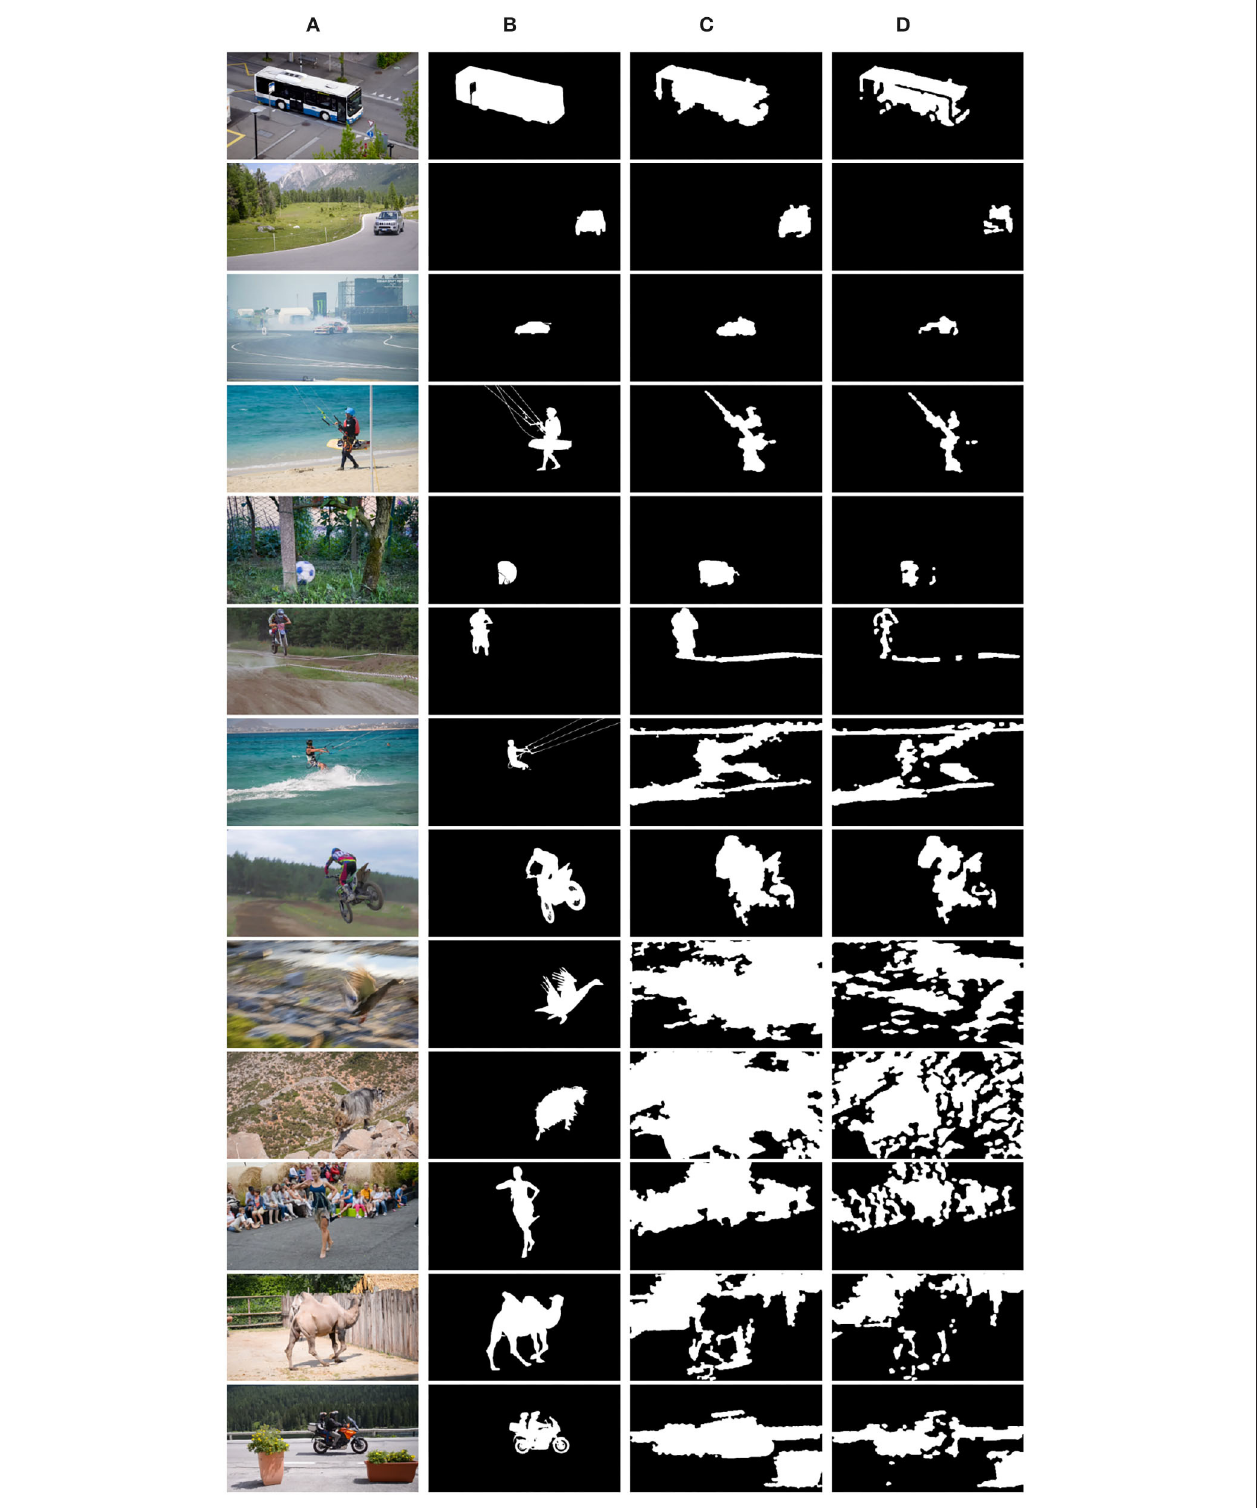
FIGURE 10 | Sample results on D AVIS-2016 dataset. From top to bottom: bus (OC), car-turn (FC), drift-chicane (FC), kite-walk (FC), soccerball (FC), motocross-bumps (MBFM), kite-surf (MBFM), motocross-jump (MBFM), mallard-fly (DB), goat (BC), dance-twirl (BC), camel (CS), motorbike (MBFM). (A) Reference frame, (B) ground truth, (C) GCKs-A, and (D)